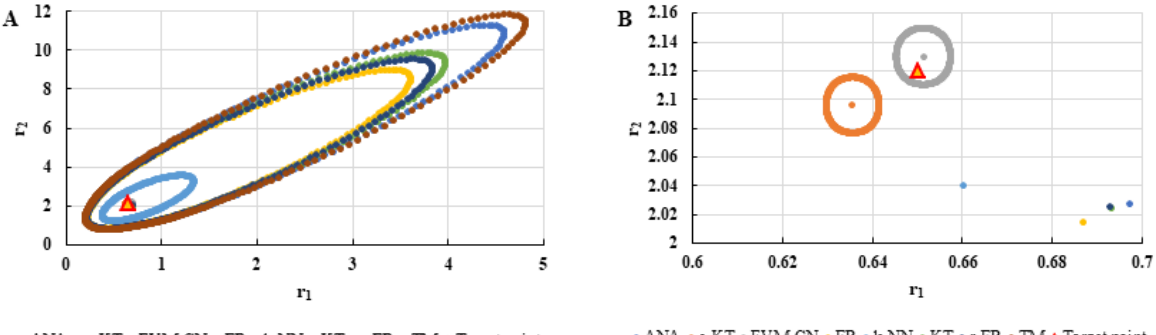
Figure 14. The JCR of analyzed methods for reactivity ratios calculation for MC2 imposed condition.